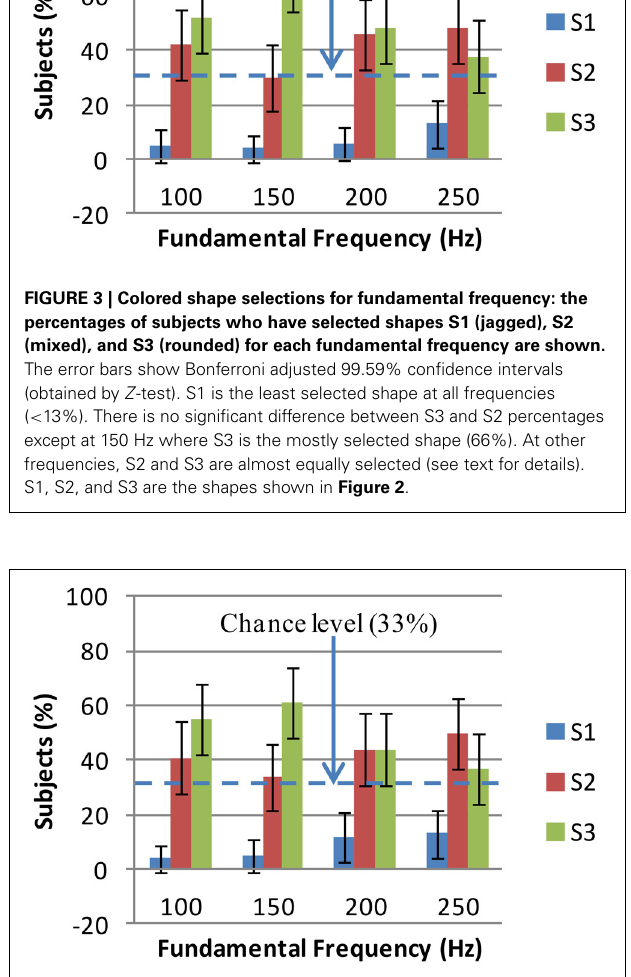
FIGURE 4 | Grayscale shape selections for fundamental frequency: the percentages of subjects who have selected shapes S1 (jagged), S2 (mixed), and S3 (rounded) for each fundamental frequency are shown. The error bars show Bonferroni adjusted 99.59% confidence intervals (obtained by Z -test). S1 is the least selected shape at all frequencies (<13%). There is no significant difference between S3 and S2 percentages except at 150 Hz where S3 is the mostly selected shape (61%). At other frequencies, S2 and S3 are almost equally selected (see text for details). S1, S2, and S3 are the shapes shown in Figure 2